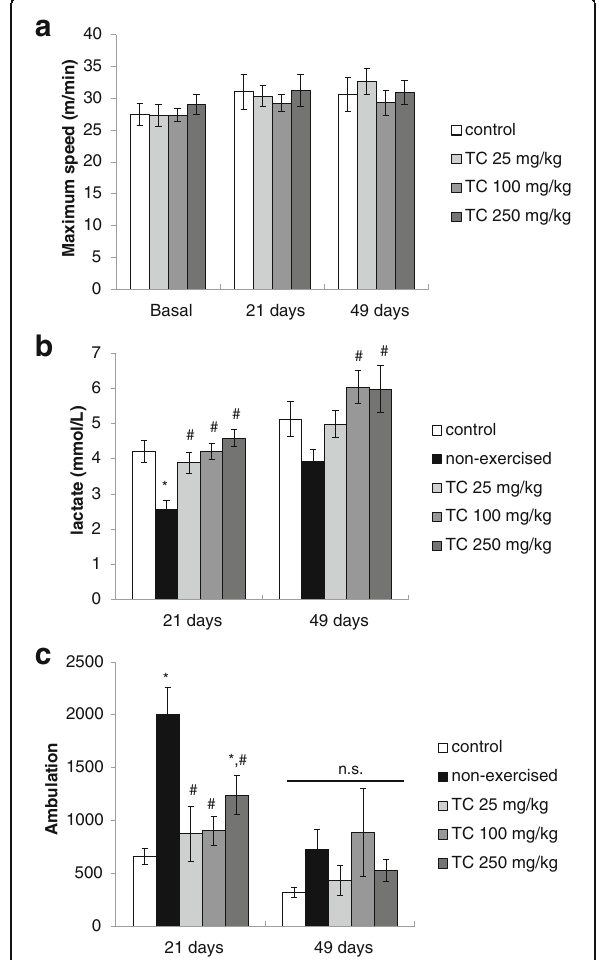
Fig. 2 a Fatigue time (maximum speed), b plasmatic lactate level and ( c ) spontaneous locomotor activity of mice chronically treated with Trichilia catigua (TC) hydroalcoholic extract (25, 100 and 250 mg/kg, p.o.) and subjected to the forced exercise on treadmill. The columns and bars express the mean ± SEM (n = 8 – 10). (*) p < 0.05: statistically different of control exercised group; (#) p < 0.05: statistically different of non-exercised control group.